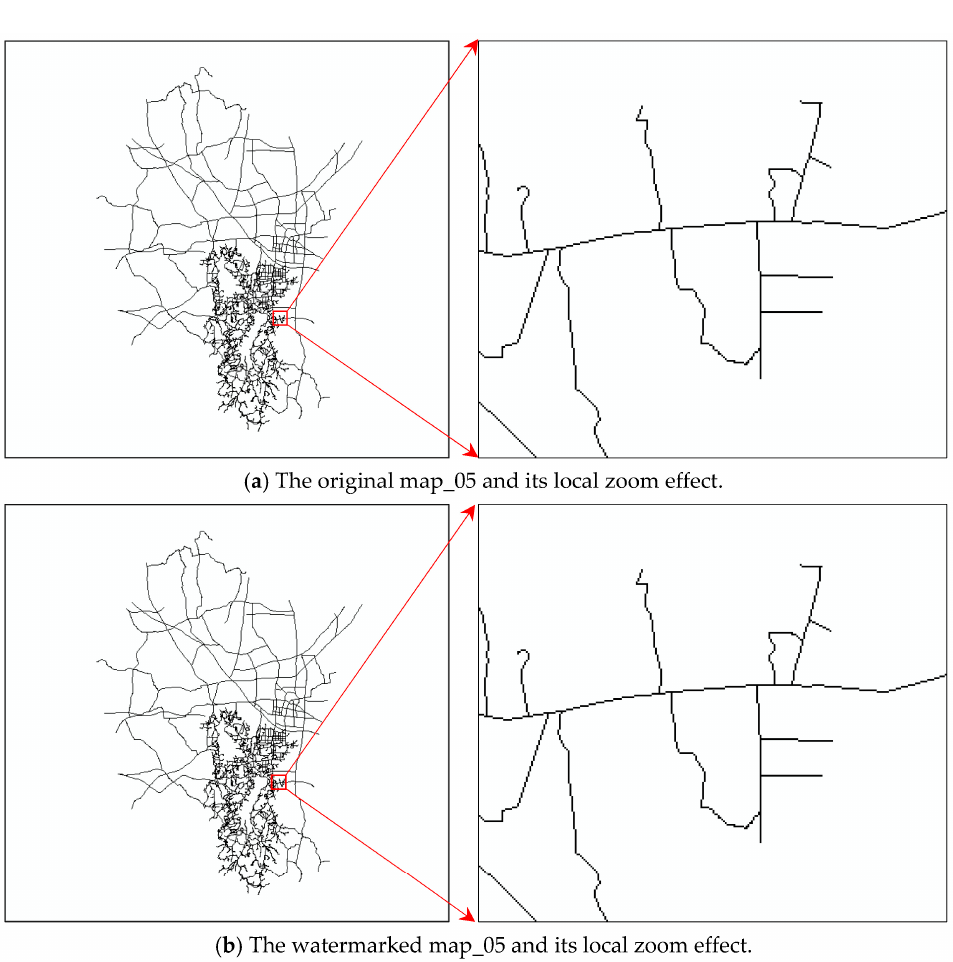
Figure 12. An example of invisibility analysis.